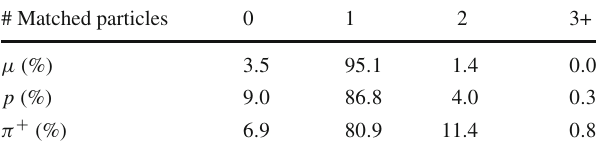
Table 2 Pattern-recognition performance for the target muon, proton and charged pion in simulated BNB CC ν μ interactions with resonant pion production. The total number of events was 47,754 and 70.5% were deemed to have exactly one reconstructed particle matched